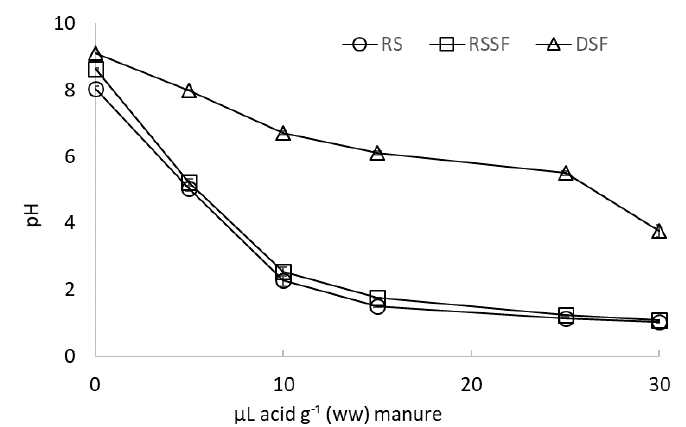
Figure 1. Titration curves for raw dairy slurry (RS), dairy slurry solid fraction (RSSF), and digestate solid fraction (DSF) acidified with sulfuric acid, presented as mean values of three replicates. Error bars indicate standard deviation.